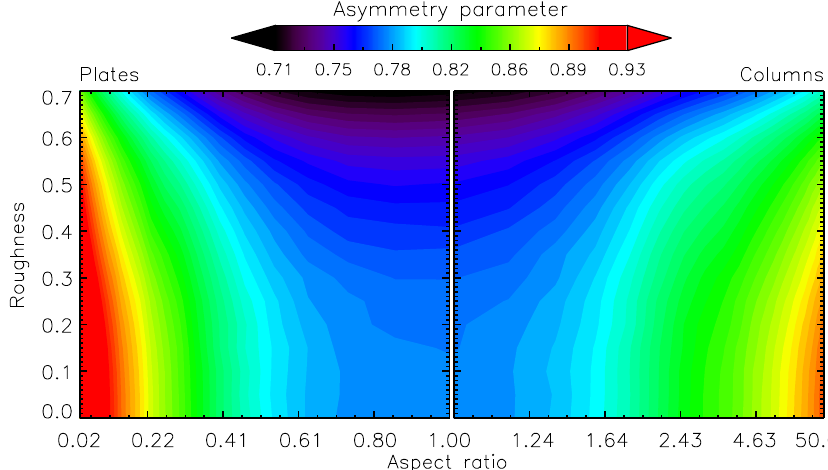
Fig. 1. Asymmetry parameters of plates and columns at 864nm as a function of their aspect ratio and microscale roughness.